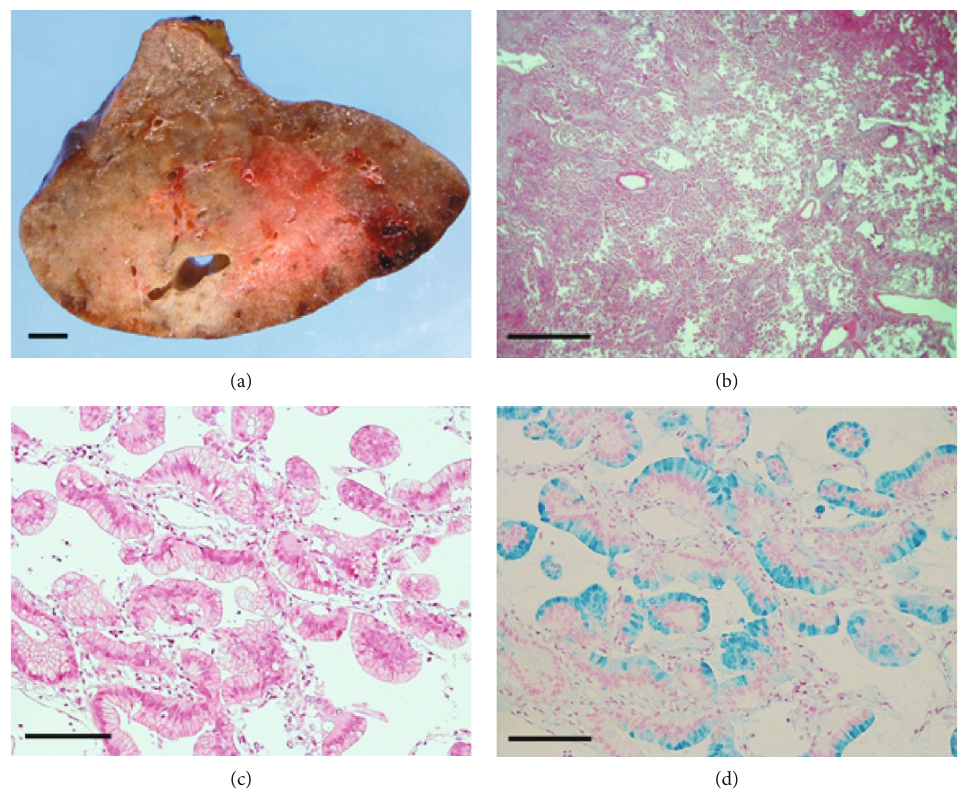
Figure 2: Left lung cancer I. (a) Gross view showing an ill-de fi ned tumor with a di ff use pneumonia-like consolidation. Scale bar: 1 cm. (b) The tumor cells exhibit lepidic or papillary growth, with detached tumor cells scattered in the alveolar spaces. Hematoxylin and eosin (H&E) staining, scale bar: 2mm. (c) Columnar tumor cells with intracytoplasmic vacuoles are shown in a monolayer arrangement. H&E stain, scale bar: 200 μ m. (d) Multiple mucin-producing tumor cells are visible. Alcian blue stain, scale bar: 200 μ